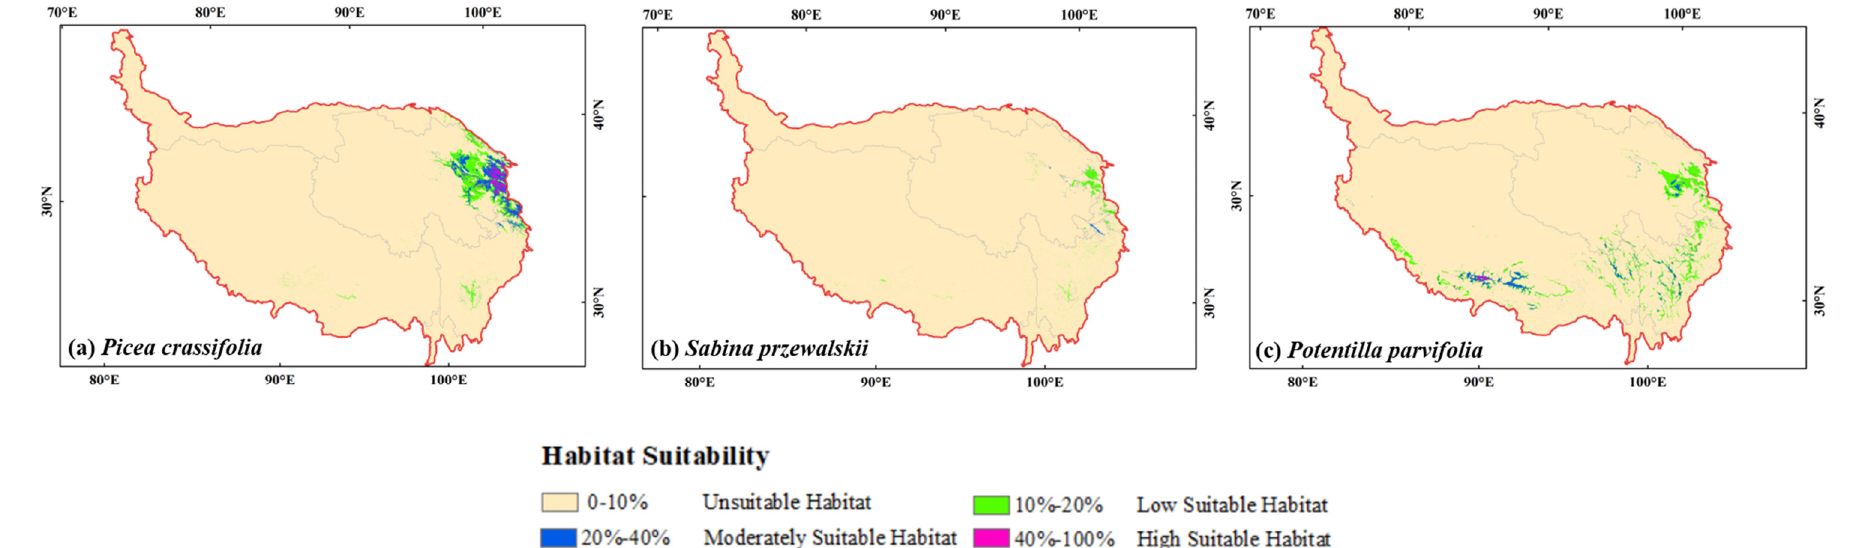
Figure 3. The current potential geographical distribution of the three species .